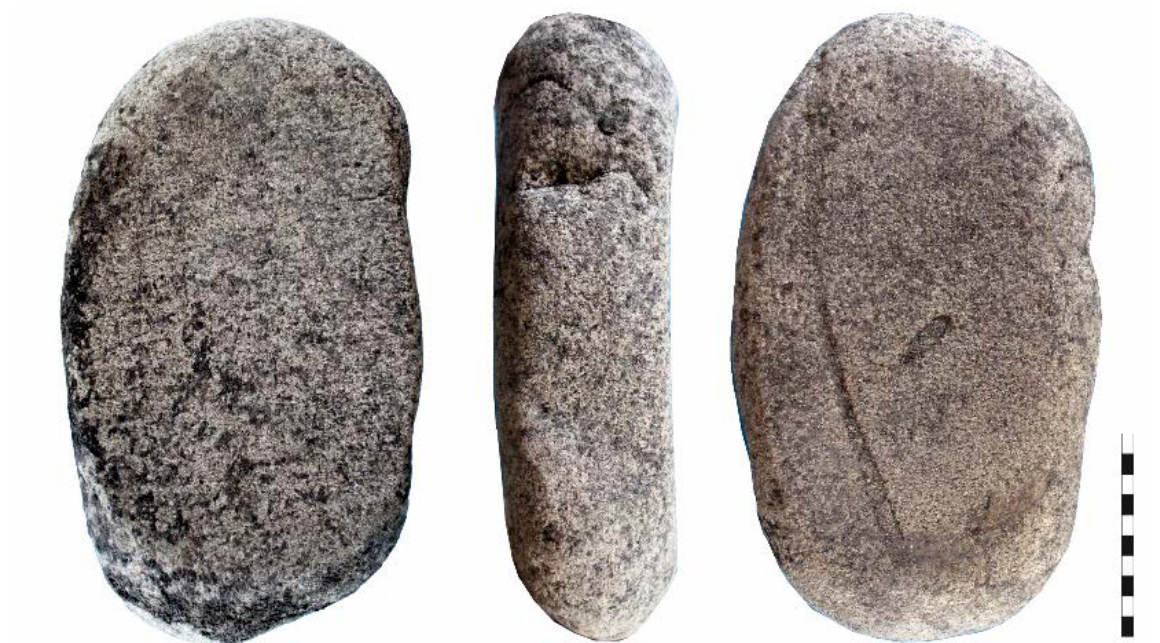
Figure 17. The grinding slab from Pit 282302 (AVGI III). Workfaces and profile (scale in cm).